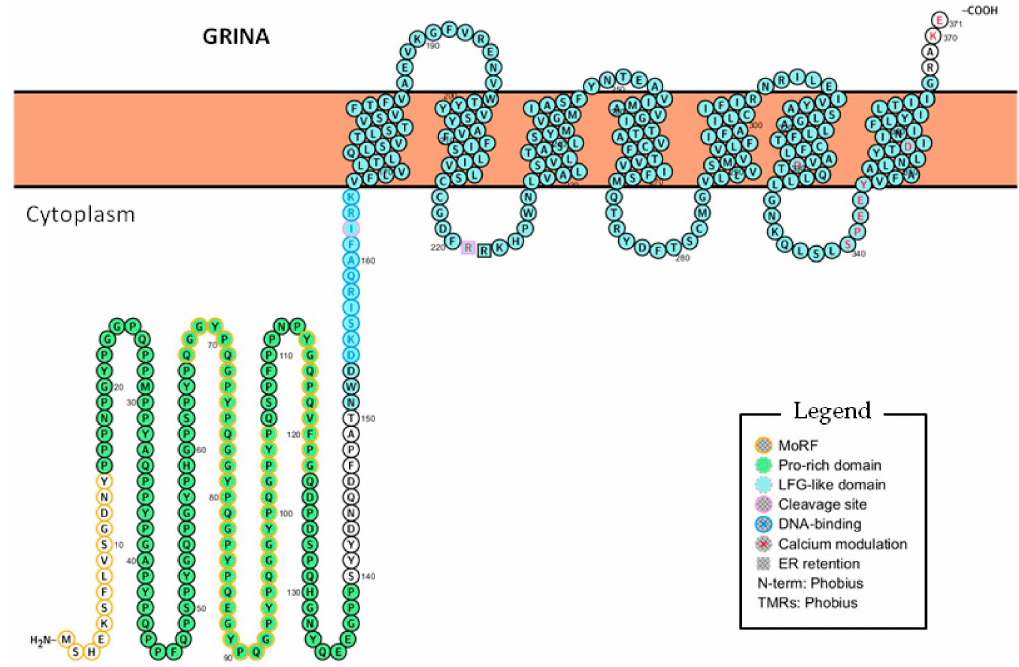
Figure 1. General representation of human Glutamate Receptor Ionotropic NMDA-Associated Protein 1 (GRINA) highlighting its domains and the most relevant features. The graph was generated using Protter v1.0